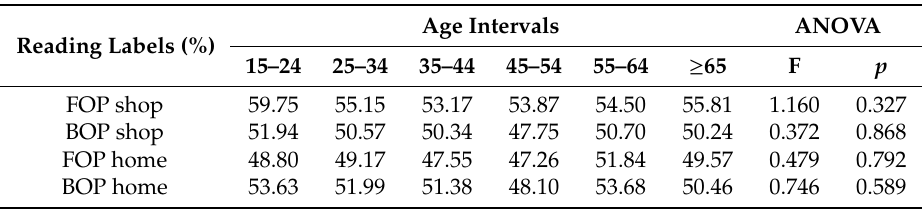
Table 2. Reading food labels by age.